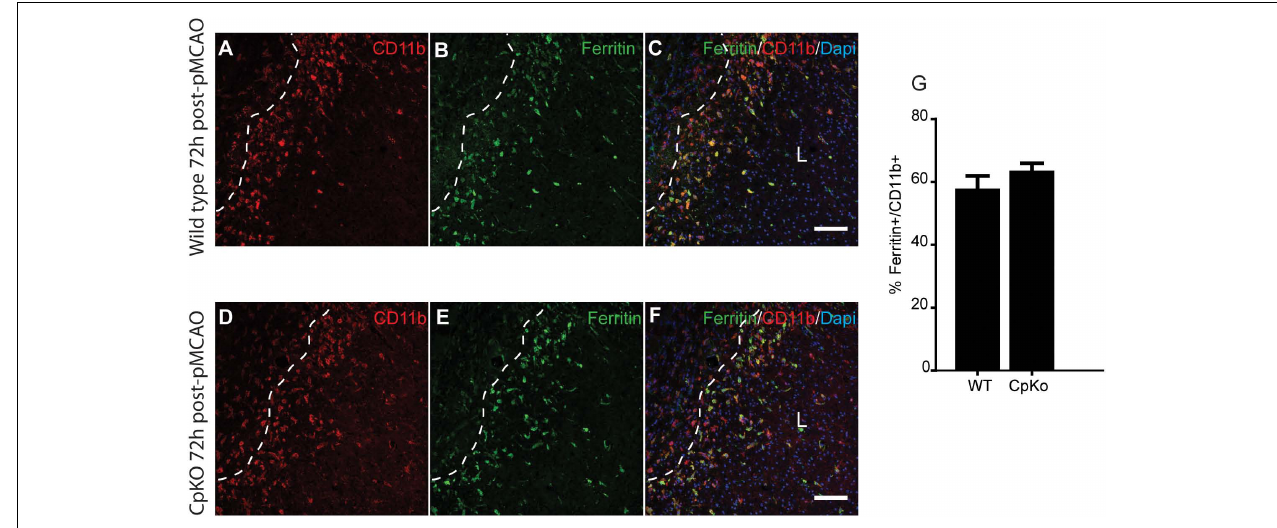
FIGURE 6 | Immunofluorescence labeling for ferritin in macrophage/microglia. Double immunofluorescence labeling show that ferritin+/CD11b+ macrophage/microglia are located mainly in the lesion (L) along the lesion border in both wildtype (A–C) and CpKO (D–F) mice 72 h after pMCAO. Dotted line demarcates the lesion boundary. The merged images (C,F) show CD11b, ferritin and DAPI nuclear staining. Note that the number of CD11b+/ferritin+ doubled labeled cells are not significantly different in the two genotypes (G) . Scale bar = 100 µ m.